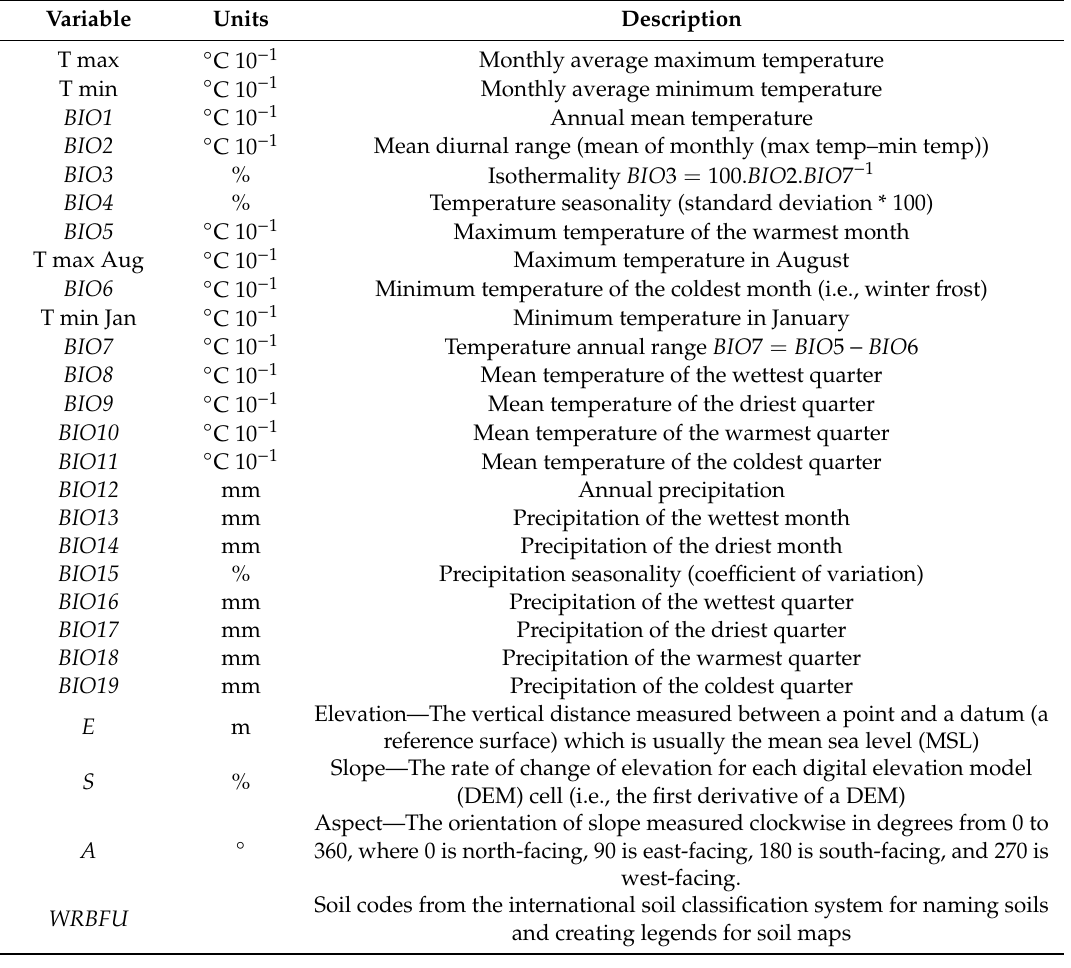
Table 1. Climatic, topographic, and soil